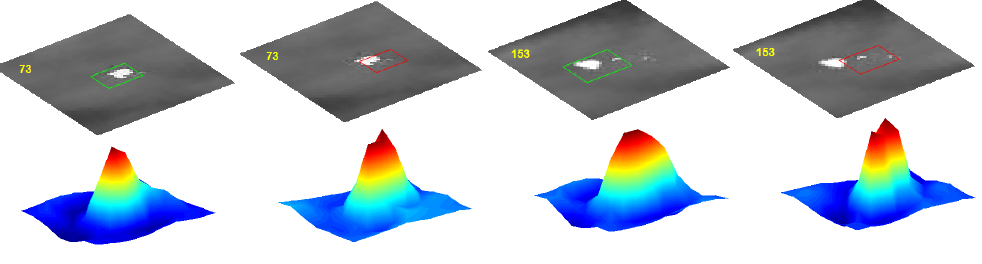
Figure 10. Visualization of the tracking results.